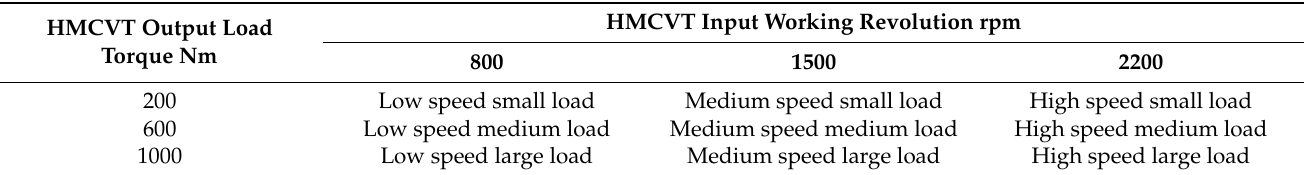
Table 1. Factor level combination of the agricultural tractor full-use